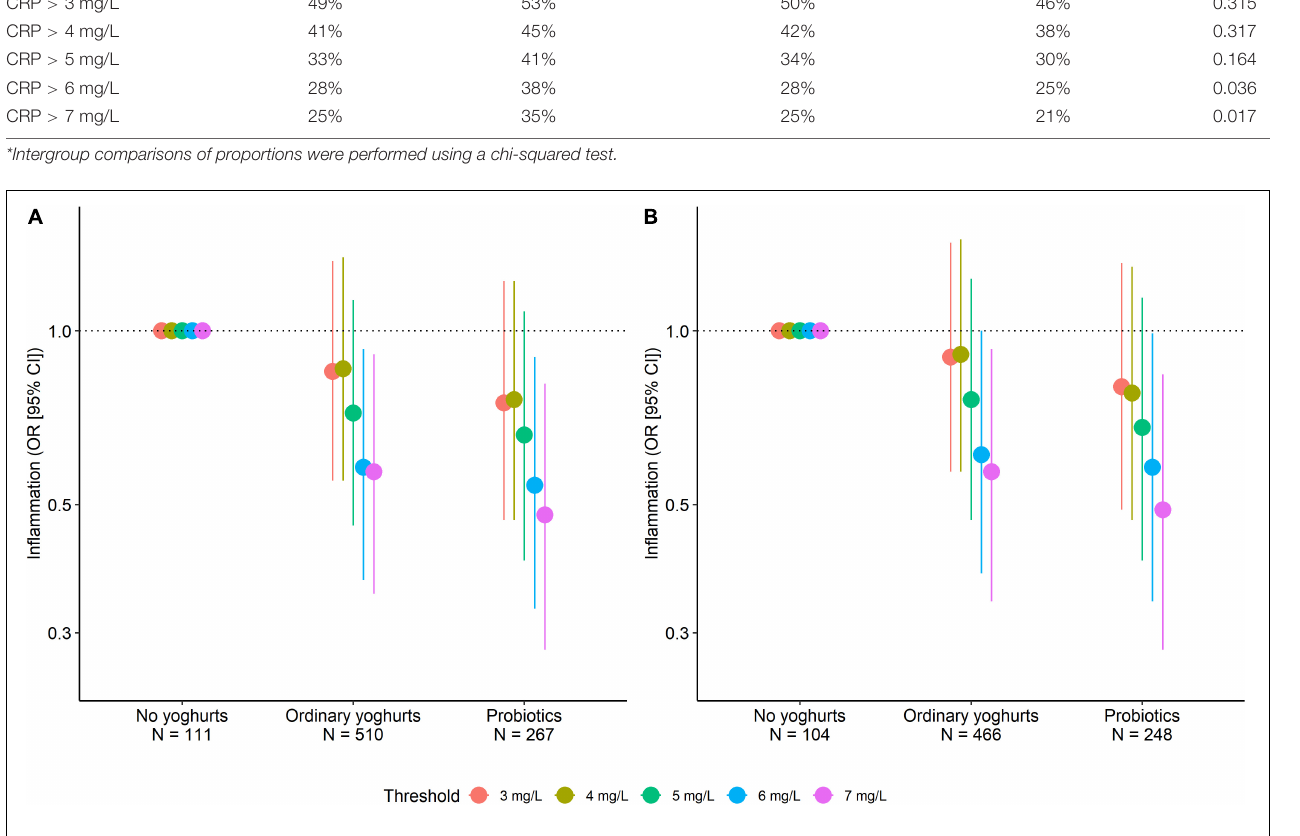
stage, and intakes of starch, eggs, sweet snacks, protein, fibre, and